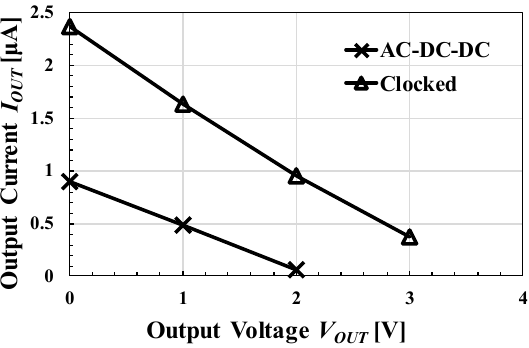
Figure 27. Simulated I OUT as a function of V OUT ( f IN = 1 kHz, f CLK = 1 MHz, V DD = 0.5 V, R EH = 500 Ω ).